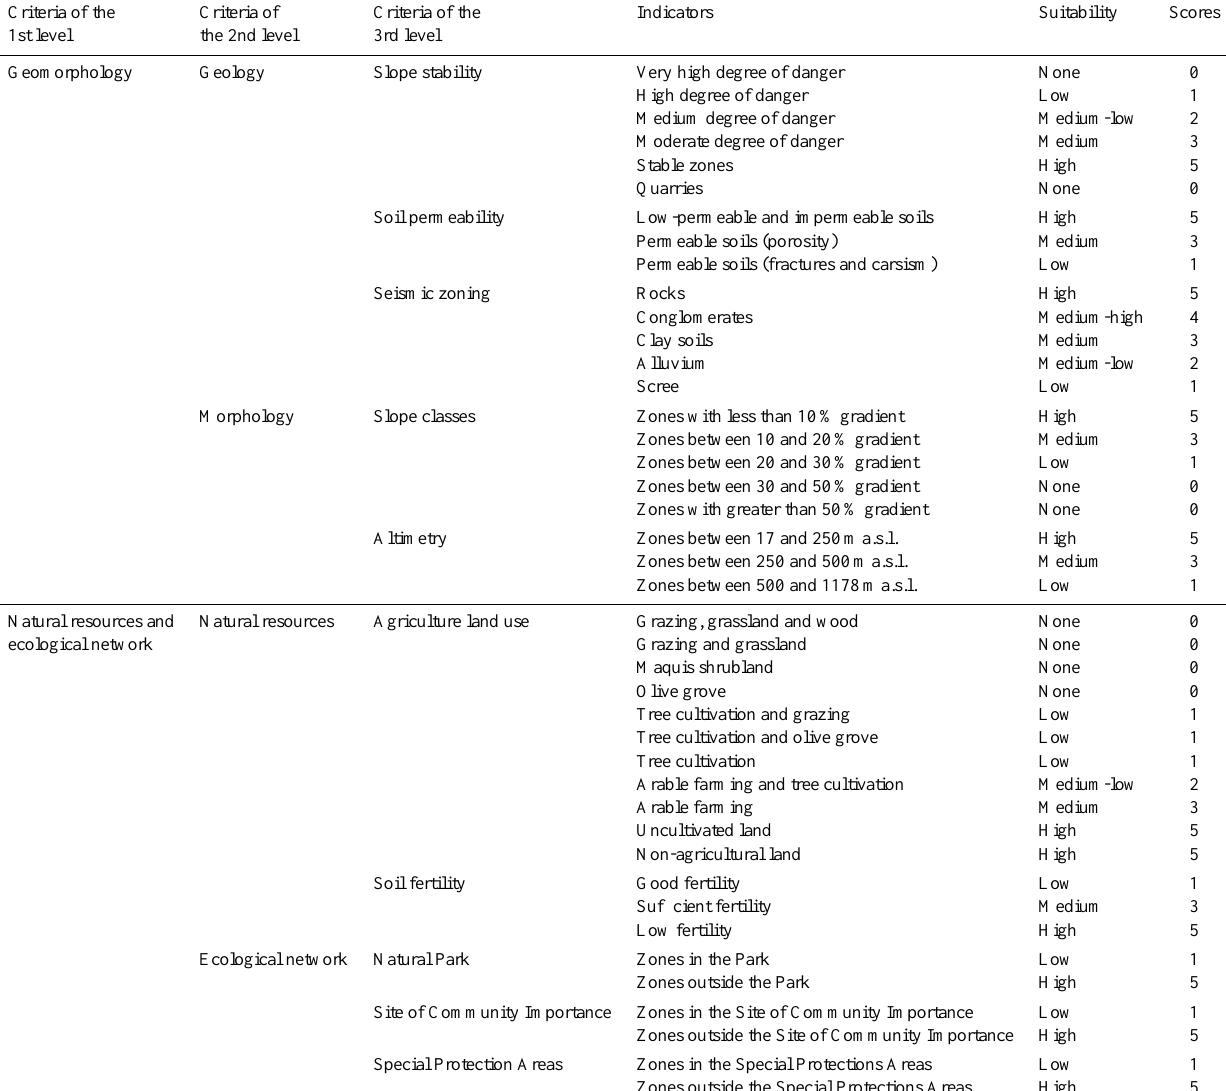
Table 1. Hierarchical structure of criteria and indicators for the urbanization process.